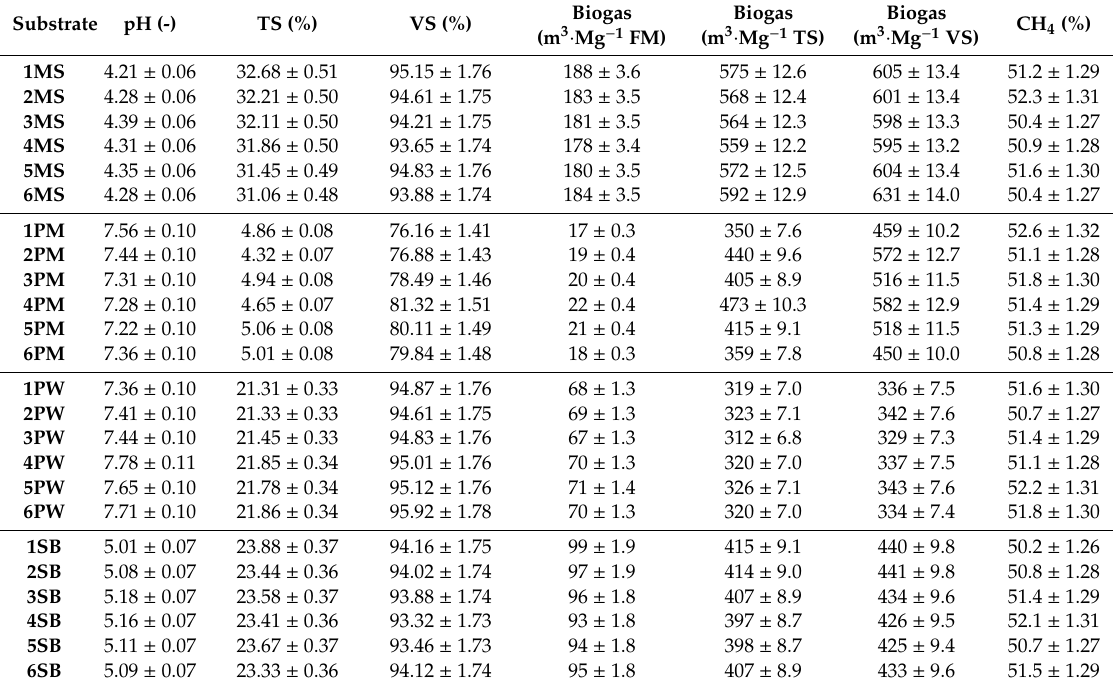
Table 1. Physicochemical properties and the laboratory-scale biogas e ffi ciency of the substrates with the uncertainty of results, based on